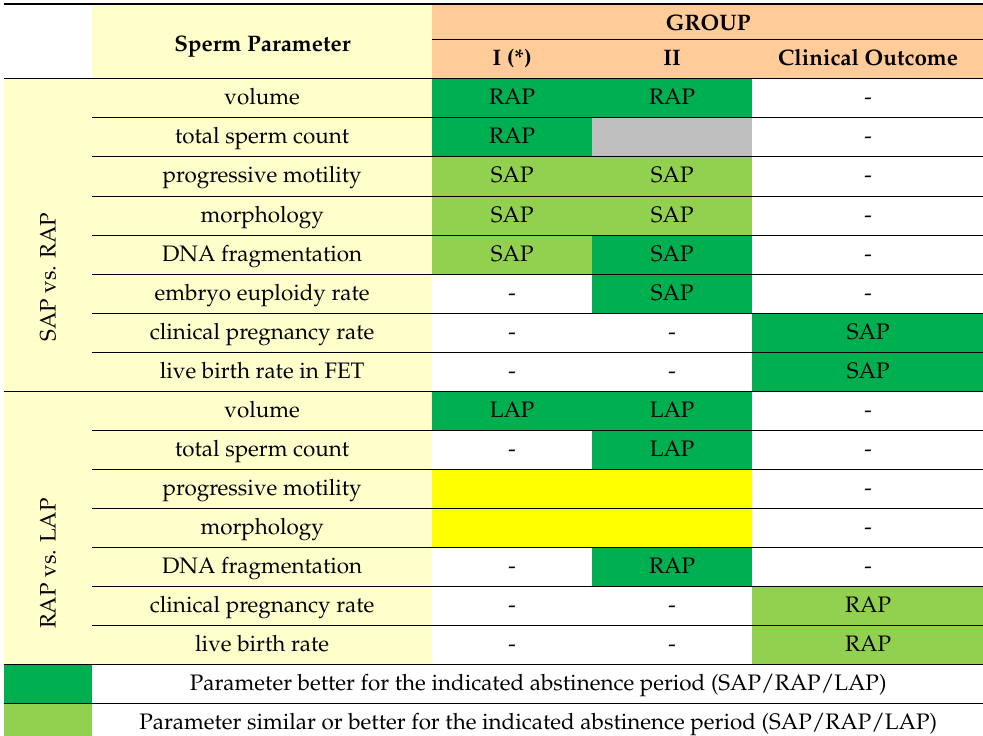
Parameter better for the indicated abstinence period (SAP/RAP/LAP) Parameter similar or better for the indicated abstinence period (SAP/RAP/LAP) Parameter similar between compared abstinence periods Conflicting